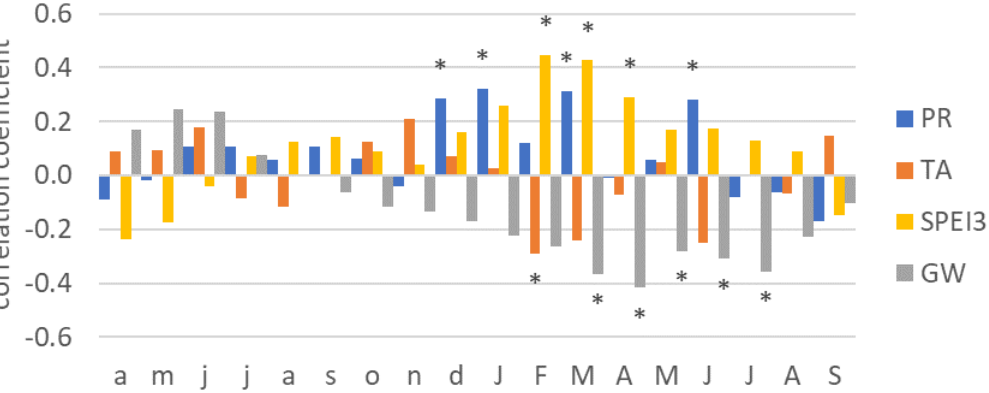
Figure 3. Correlation coefficients between the TRWI series and hydro-climatic variables PR, TA, the 3-month standardized precipitation and evaporation index (SPEI3), and GW for the period of 1961–2017. Months from April of the preceding year (lowercase initials) to tree-ring formation to September of the growing year (uppercase initials) are included; * marks significant correlation at p < 0.05 level.